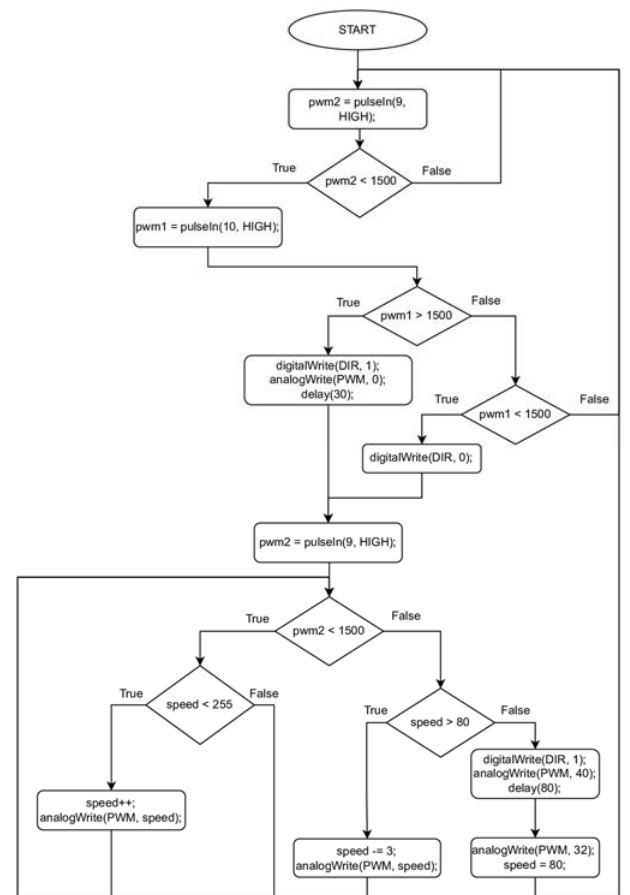
Figure 9. The algorithm of operation of the equipment for lowering and lifting the measurement module.